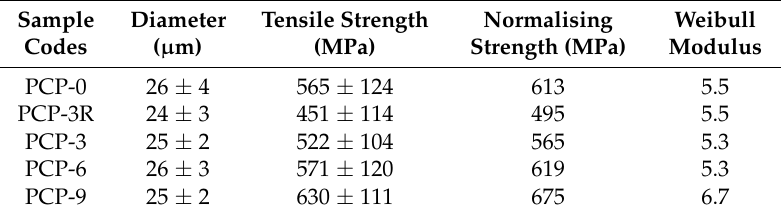
Table 2. Diameters and Weibull parameters of coated/uncoated fibres ( n = 30). The tensile strength values are also included for the ease of